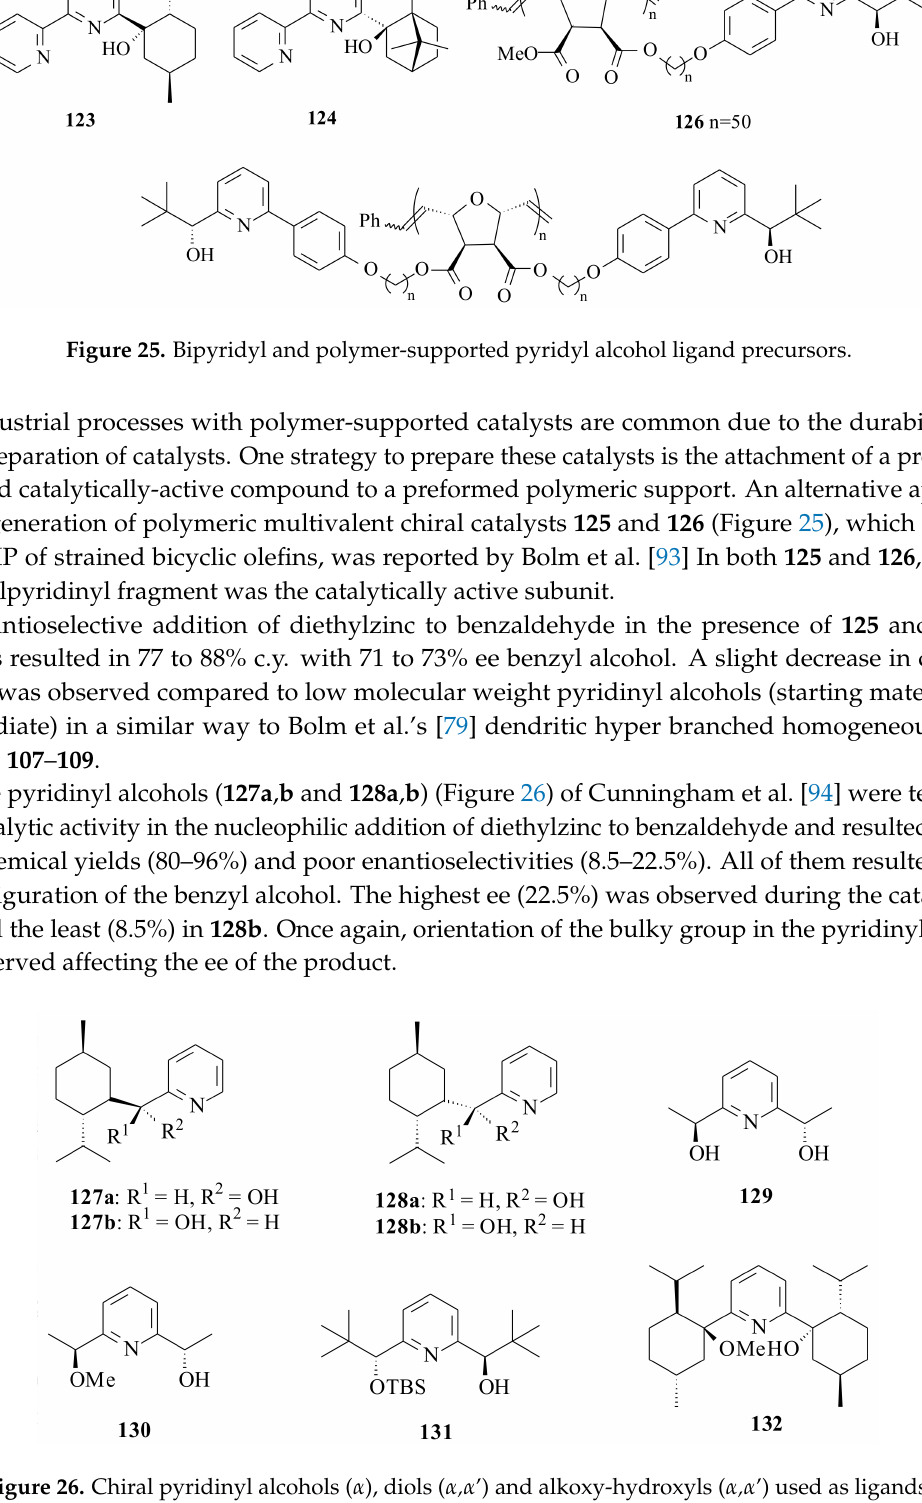
Figure 26. Chiral pyridinyl alcohols ( α ), diols ( α , α ’) and alkoxy-hydroxyls ( α , α ’) used as